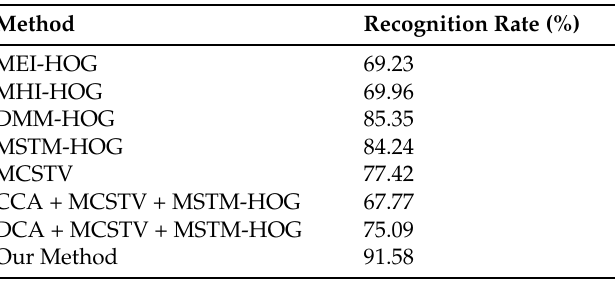
Table 6. The results on MSR-Action3D, according to Setting 2.